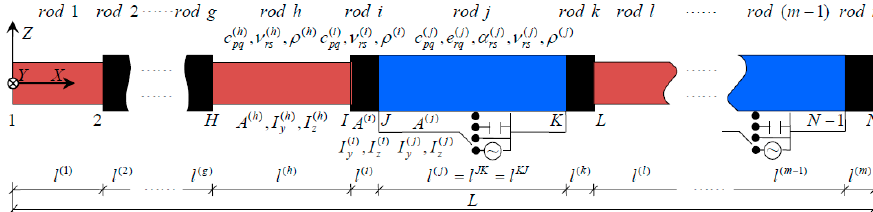
Figure 1. The unit cell of general periodic piezoelectric rods.